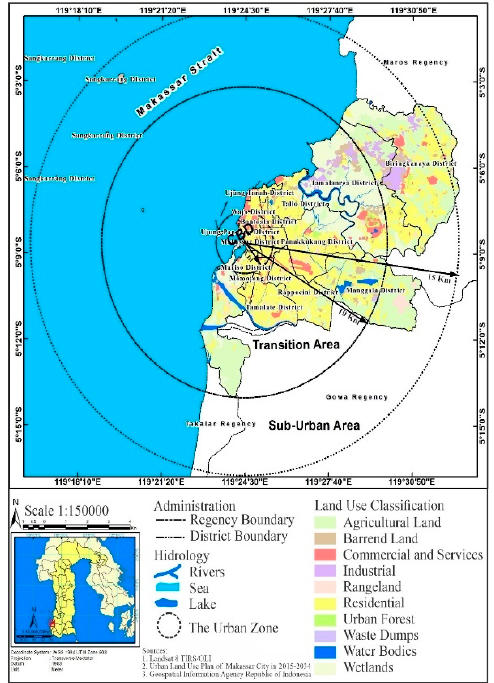
Figure 2. Makassar City as a study location.